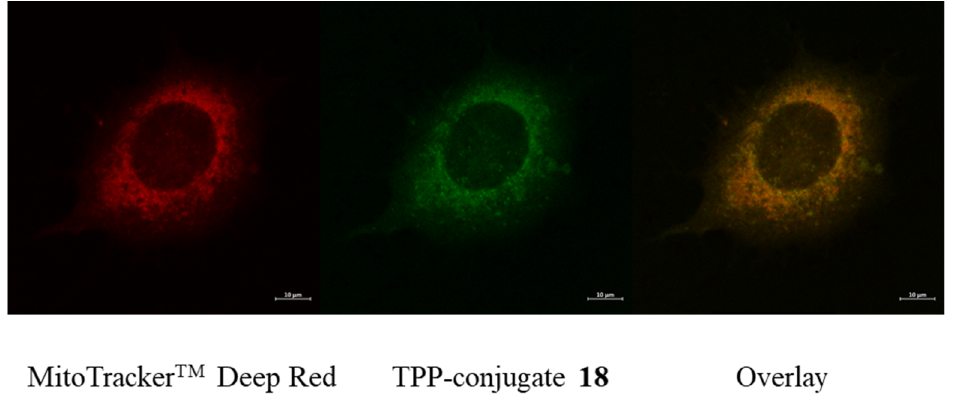
Figure 9. Fluorescent imaging of PC3 cancer cell line stained with TPP-conjugate 18 (ex/em:488/520 nm) and with MitoTracker TM Deep Red (ex/em: 596/615 nm).